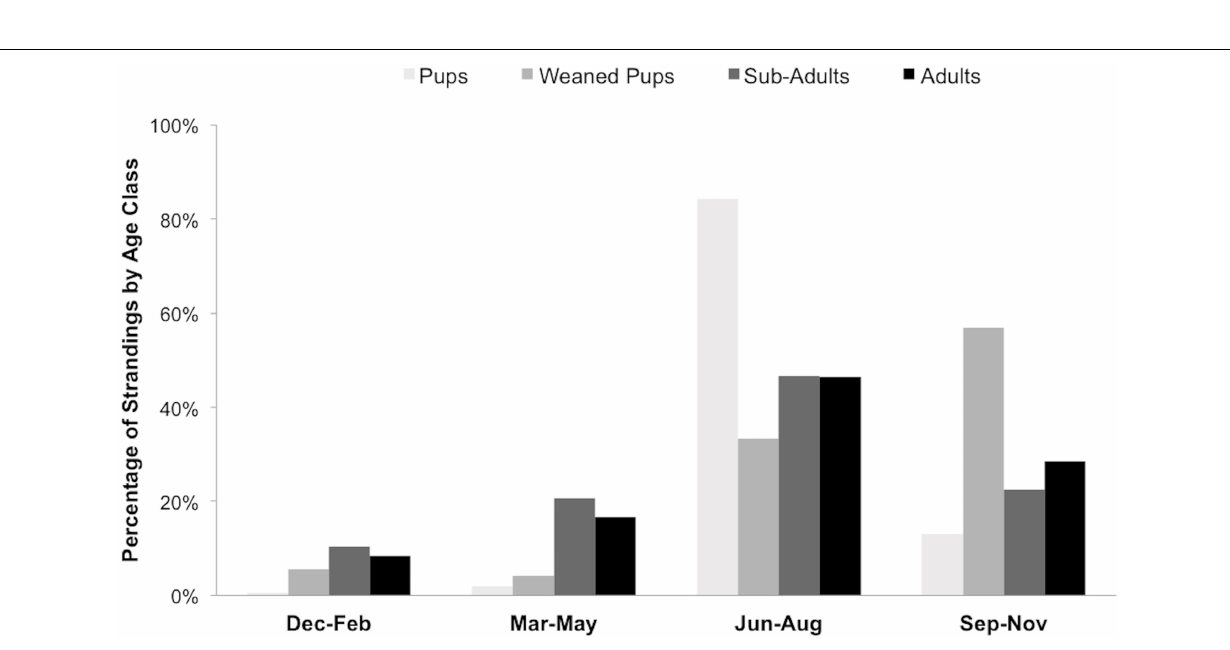
Frontiers in Marine Science |